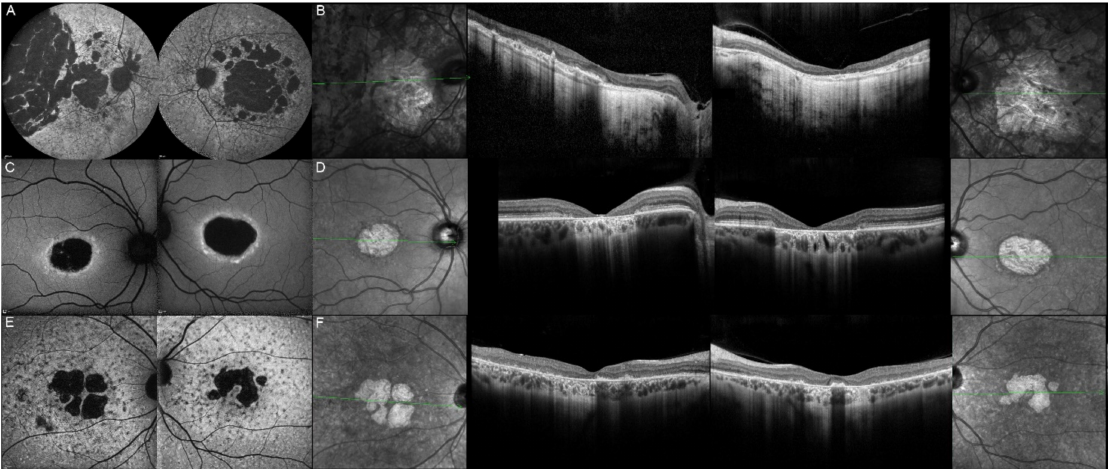
Figure 14. “Atrophy” clinical phenotype. FAF ( A ) and OCT ( B ) imaging of STGD1 patient 11/III.1 compound heterozygous for the c.1807T>C p.(Tyr603His) and c.4496T>C p.(Leu1499Pro) ABCA4 variants. FAF ( C ) and OCT ( D ) imaging of STGD3 patient 12/II.2 harboring the pathogenic c.810C>G p.(Tyr270*) ELOVL4 variant. FAF ( E ) and OCT ( F ) imaging of patient 19/III.2 affected by c.422A>G p.(Tyr141Cys) PRPH2 -associated autosomal dominant Stargardt-like macular dystrophy.